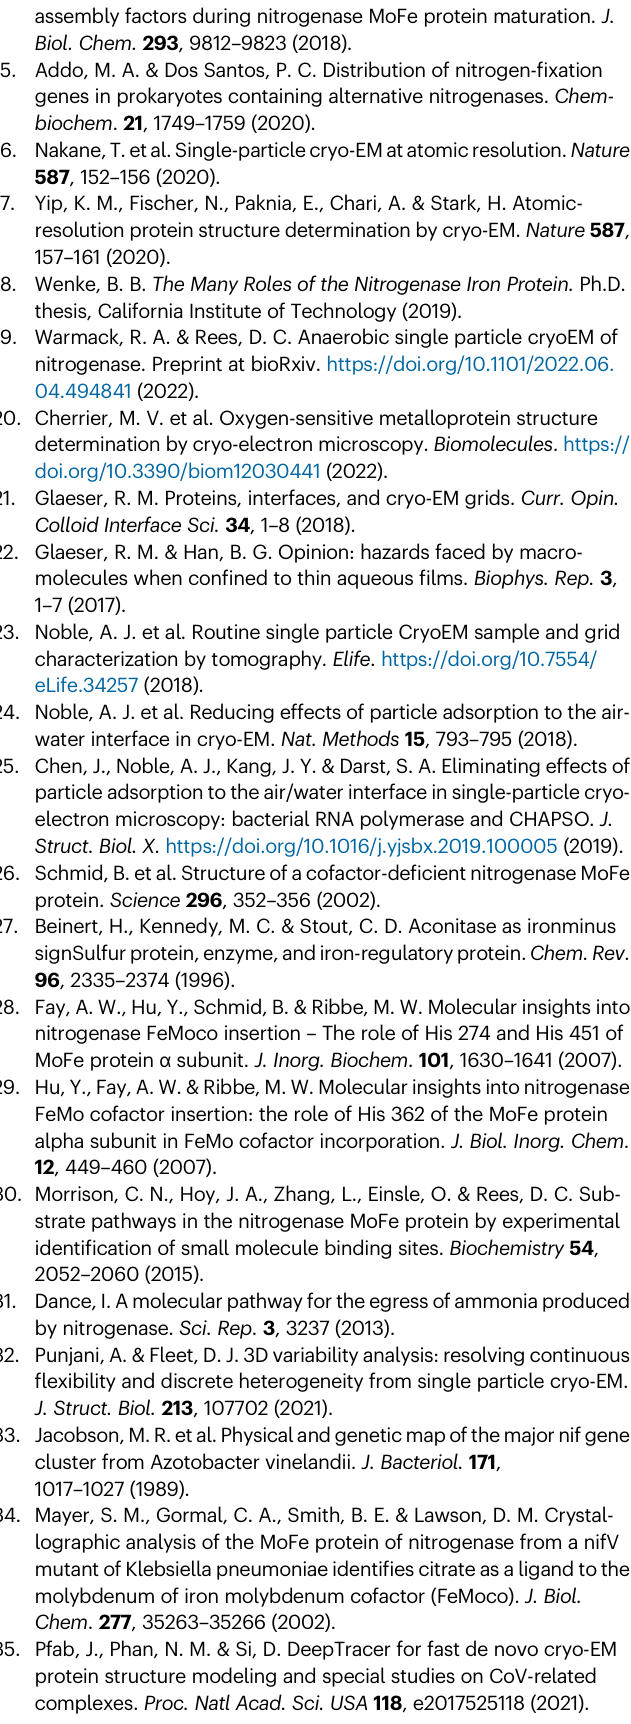
Figure preparation and presentation Structural fi gures were prepared in ChimeraX and Pymol 56 . Graphs were generated and statistical analysis were performed using